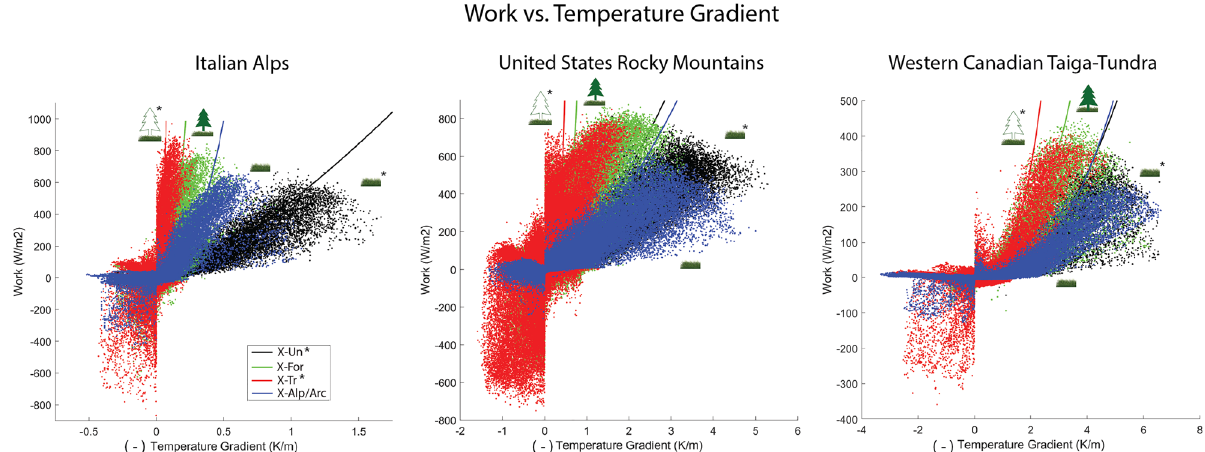
Figure 3. The work versus resultant temperature gradient for the three site pairs summarized in Table 1. The negative of the resultant temperature gradient is plotted on the x-axis. Thus, the positive x-axis refers to a negative temperature gradient such that larger values indicate stronger declines in temperature from the earth surface to the atmosphere. The negative x-axis indicates positive temperature gradients, or temperature inversions. Data points represent half-hourly simulation timesteps over the entire study period (Italy, 2 years; United States, 6 years; Canada, 3 years). The starred vegetation scenarios ( X-Un* & X-Tr* ) indicate counterfactual scenarios. For every region, on the positive x-axis the simulated trees ( X-Tr ) scenario above the treeline performs the most work for the resultant temperature gradient than the other scenarios when the temperature of the earth surface is warmer than that of the air above the canopy. However, when the resultant temperature gradient is positive (negative x-axis), a temperature inversion occurs (Fig. 1), resulting in the vegetation performing negative work – transporting heat in the opposite direction of the temperature gradient ( X-Tr & X-Alp/Arc ).